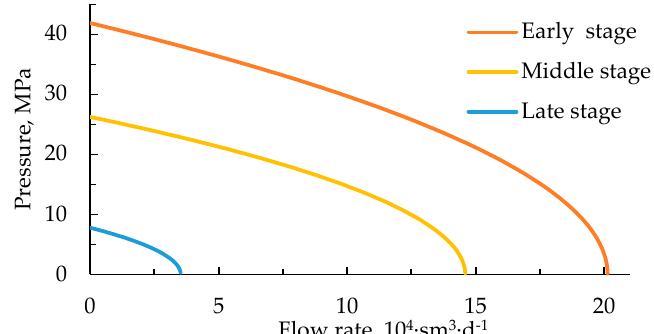
Figure 3. Inflow performance relationship curves for different periods.